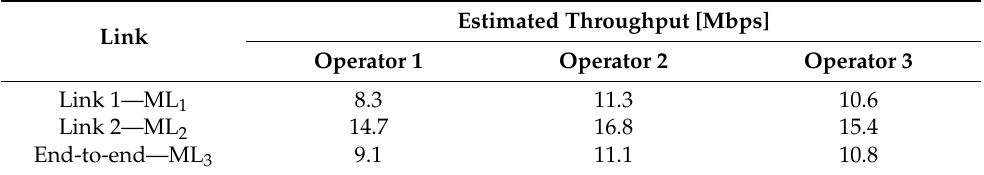
Table 2. Estimated values of throughput in link 1, link 2, and end-to-end